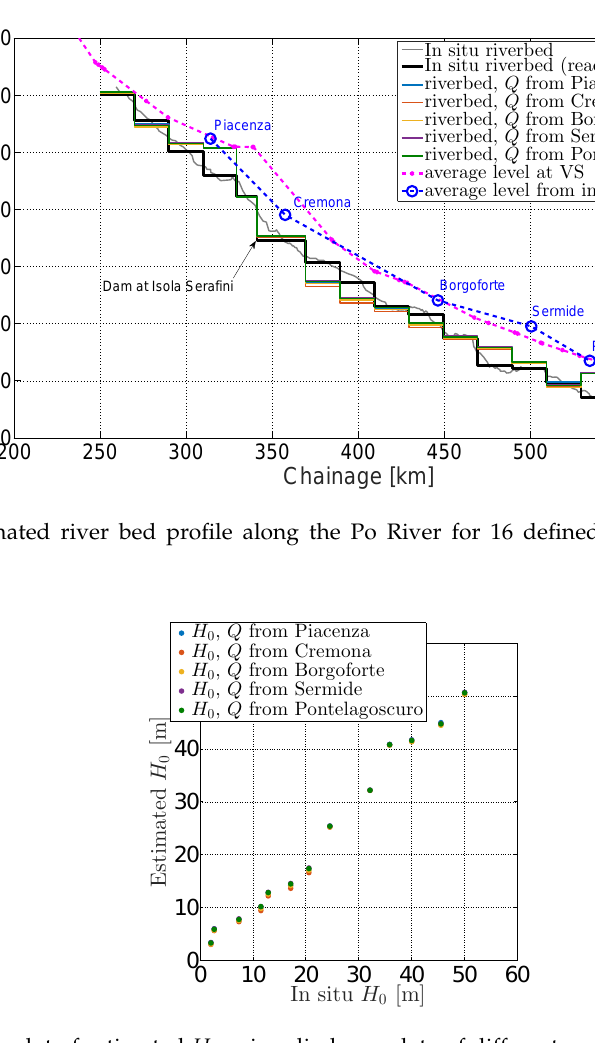
Figure 7. Scatter plot of estimated H 0 using discharge data of different gauging stations along the Po River. Table 4. Estimated river bed height H 0 using the two selected models, for which discharge data of the nearest gauge are